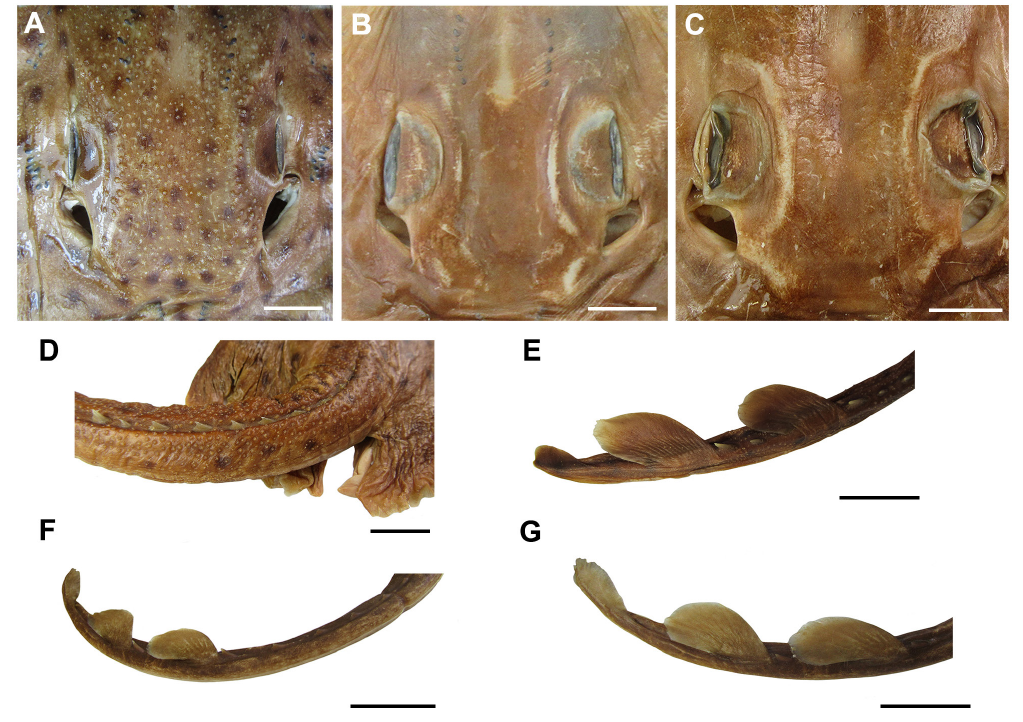
FIGURE 13 | Squamation of Atlantoraja species, dorsal body surface. A , head, D , caudal anterior region and E , caudal posterior region of A. castelnaui , UERJ 1853, male, 593 mm TL. B , head and F, caudal region of A. cyclophora , MNRJ 117184, female, 583 mm TL. C , head and G , caudal region of A. platana , UERJ 1383, male, 372 mm TL. Scale bars = 20